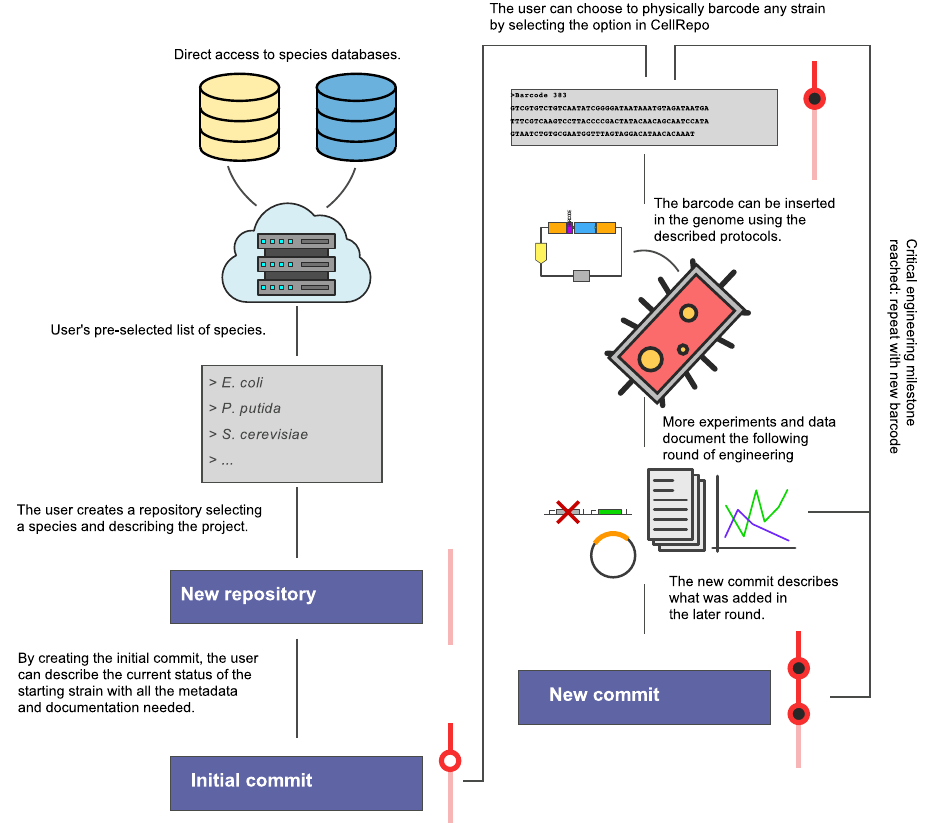
Fig. 4 CellRepo usage work fl ow. The user can choose from species directly linked from public databases. A new repository must be named and described to host the documentation of a project. Once created, the repository can be fi lled with commits to document the history of the strain. When a milestone strain is reached, the user can choose to generate a DNA barcode to be inserted in the genome of the